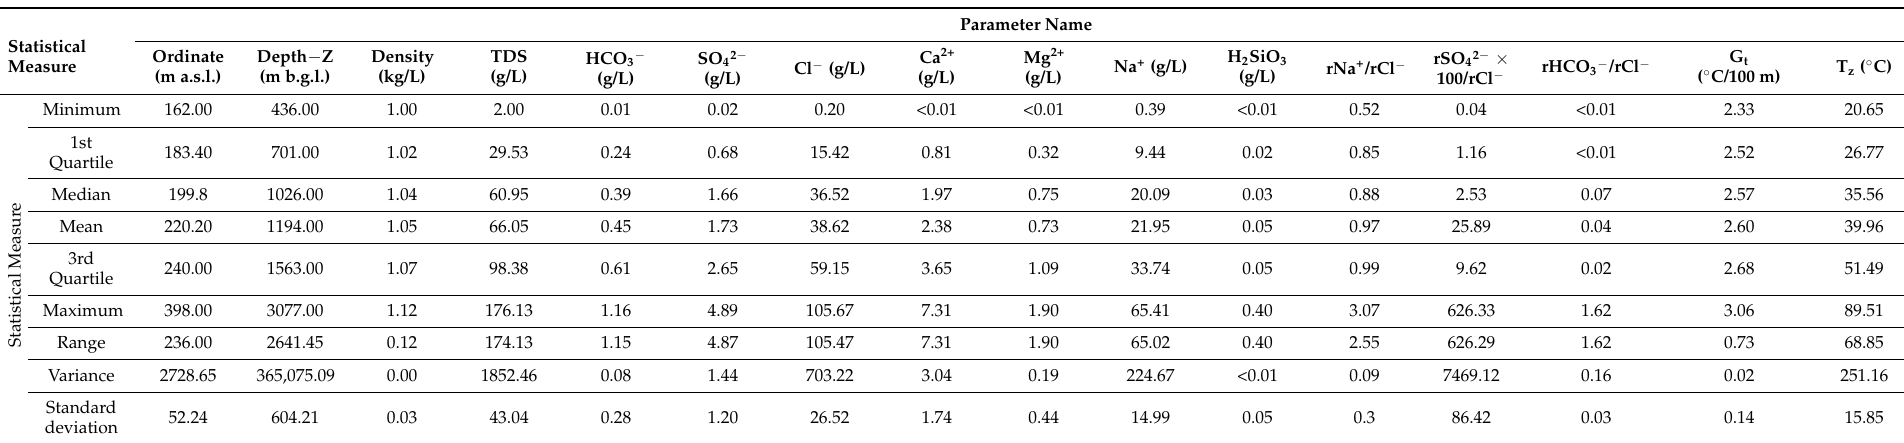
Table 2. Basic statistical measures for the analyzed